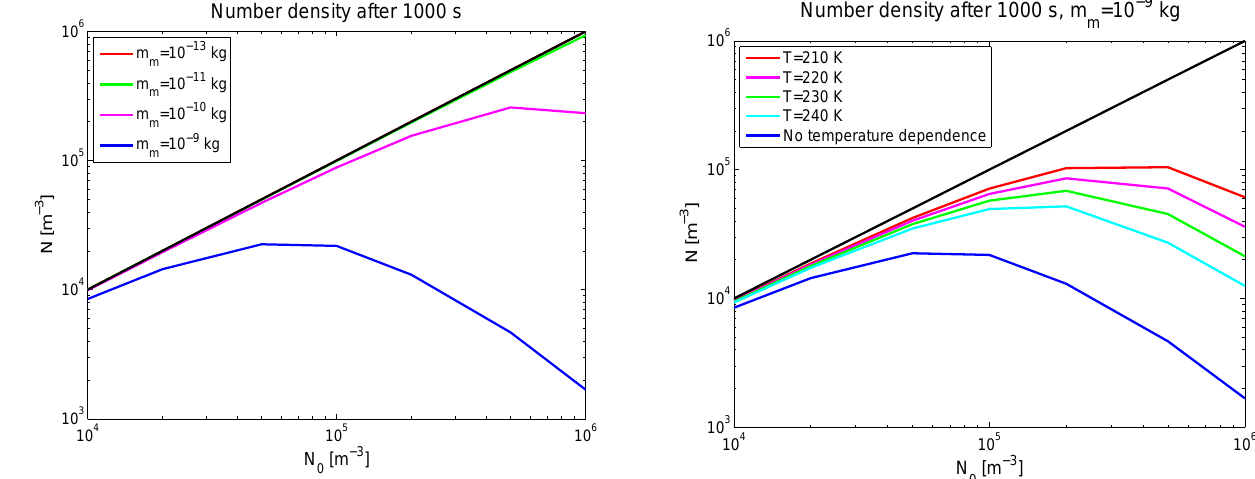
The temperature dependent collision efficiency is 0 . 21 ≤